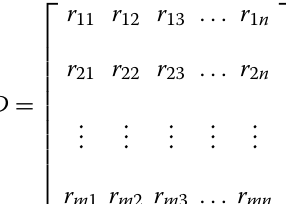
Table 1 User Feedback Scale with Fuzzy Ratings User Feedback for Benefit